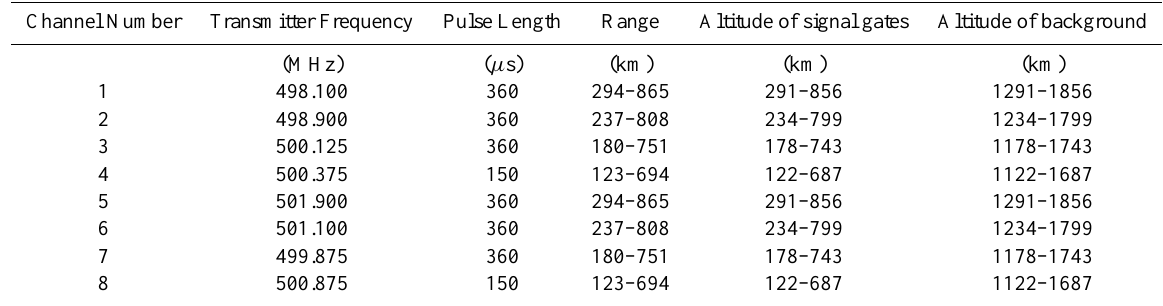
Fig. 1. Timing diagram for the 8 channels of the gup0 program. Ranges are given for the first and last samples. The background noise is Fig. 1. measured when the pulse is at a long range (between 1123 and 1921km, blue bars). Naturally enhanced ion-acoustic lines (NEIALs) in the background data therefore come from above 1000km altitude when the ESR antenna is directed along the magnetic field. Table 1. Channel parameters used in SP-NI-Widefreq at the